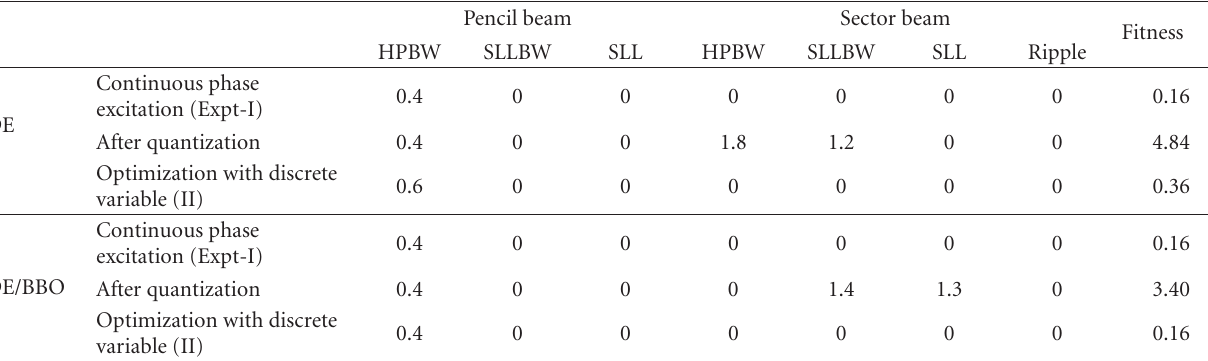
Table 3: E ff ects of quantization on di ff erent design